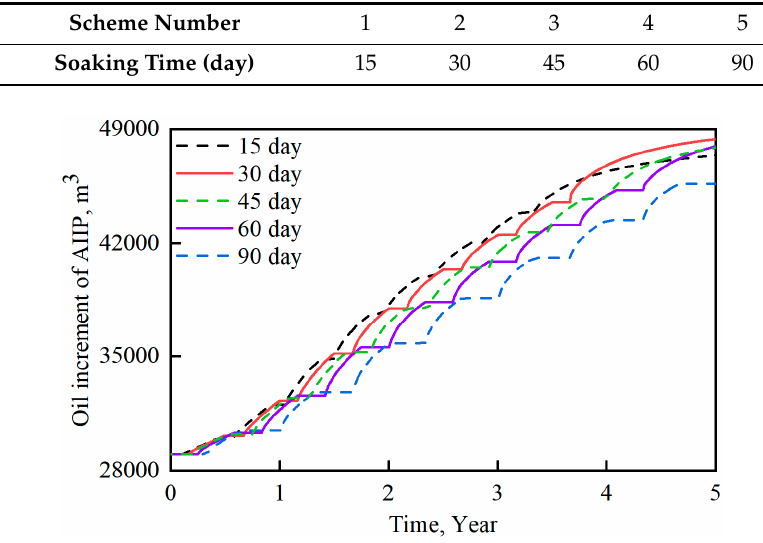
Figure 13. Comparison of oil increment of AIIP in each scheme under different soaking times. Table 11. Calculation results of di ff erent soaking times.